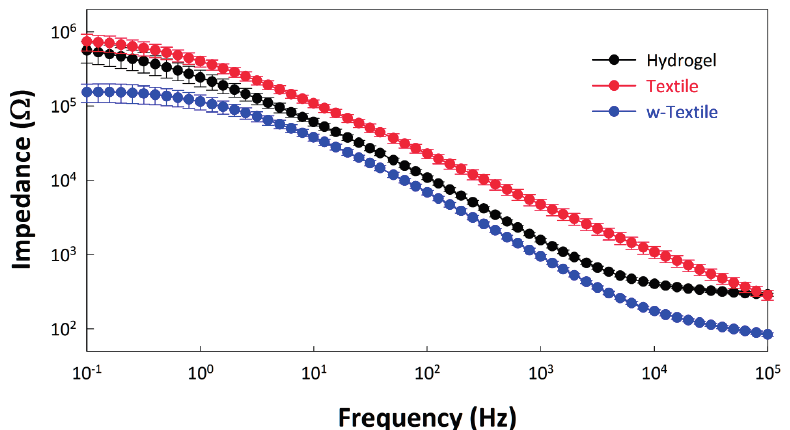
Figure 5. Impedance of the hydrogel electrode, textile electrode, and wet textile electrode (w-textile electrode) tested on TA muscle of human